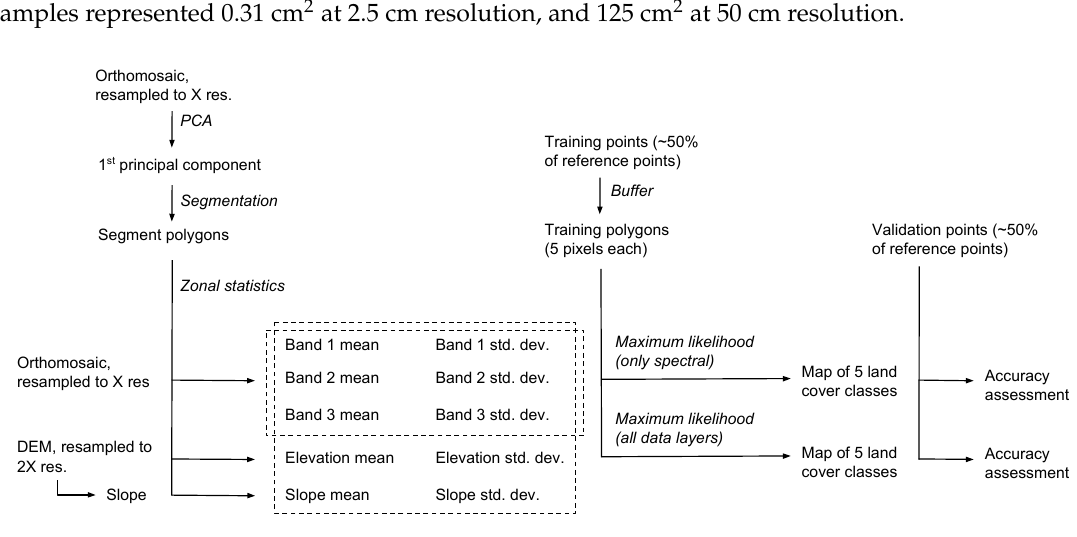
Figure 5. Workflow used for land cover classification. The process was performed four times, with X equal to 2.5 cm, 15 cm, 35 cm, and 50 cm.